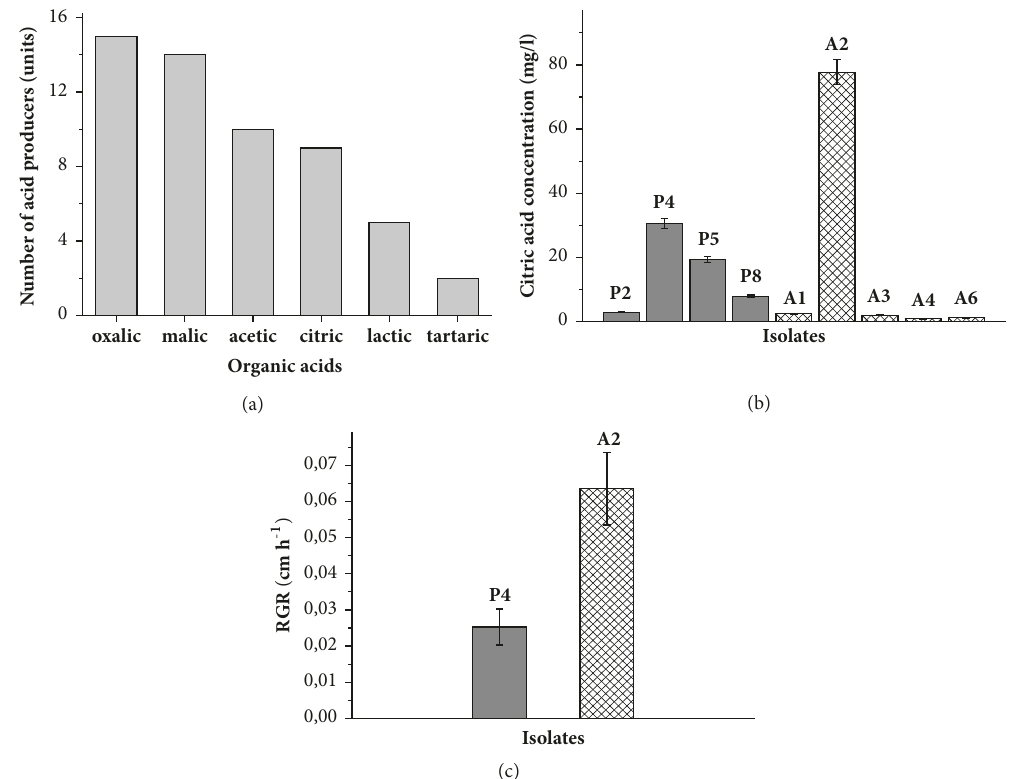
Figure 2: Metabolic activity of micromycetes after 5 days of cultivation. ( a ) The number of isolates synthesizing different organic acids; ( b ) the amount of citric acid produced by Aspergillus isolates (marked with letter A) and Penicillium isolates (marked with letter P); ( c ) radial growth rate of two dominant isolates, A. fumigatus A2 and P. brevicompactum